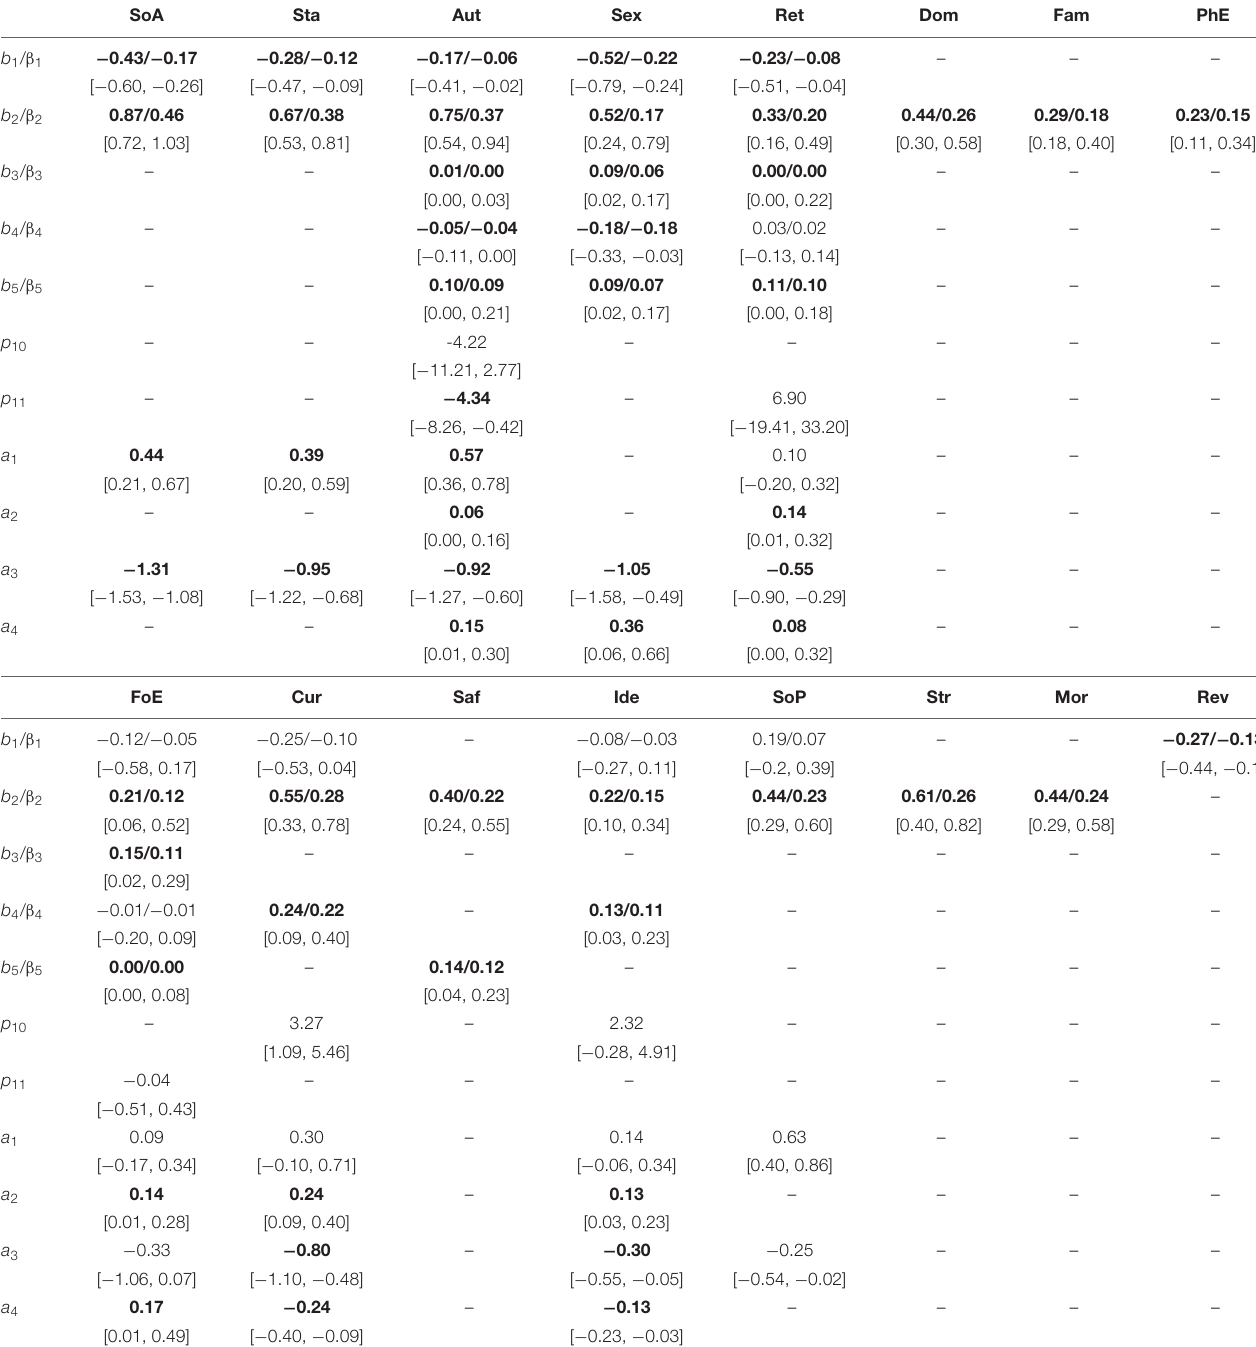
TABLE 4 | Coefficients and parameters for the 16 RSA